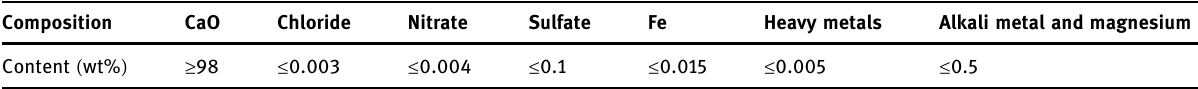
Table 4: Chemical composition of the lime Composition